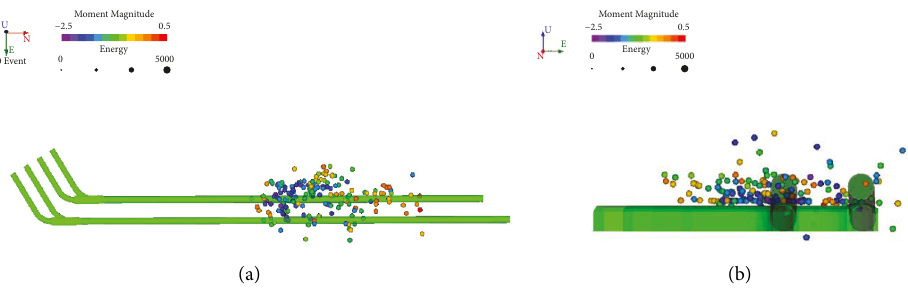
Figure 16: Spatial distribution of microseismic events in the tailrace tunnels. (a) Planform. (b) Left view.